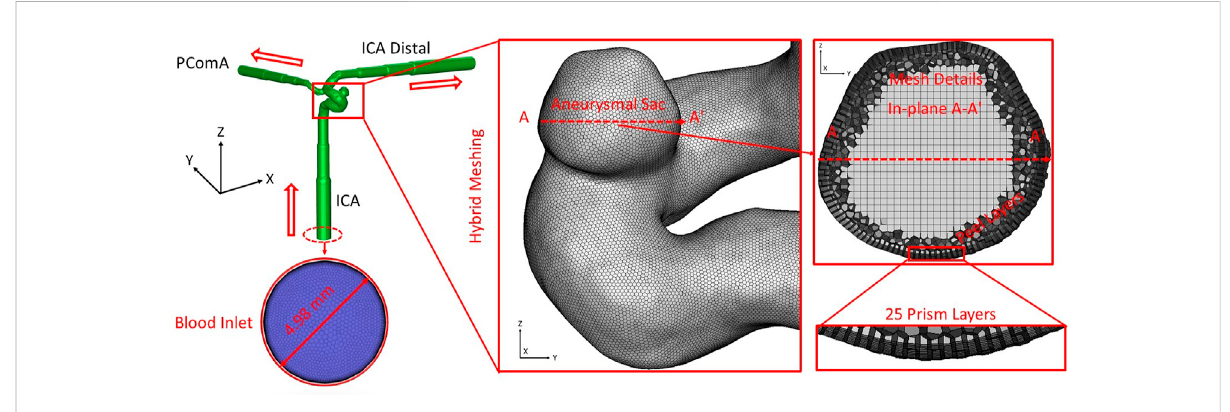
FIGURE 4 Schematic of the computational domain with hybrid mesh details in the ICASA